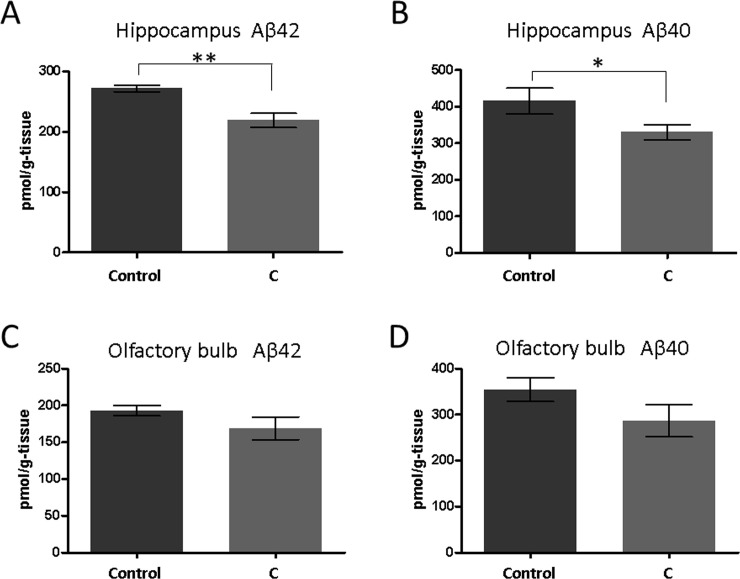
The amounts of Aβ42 and Aβ40 in the hippocampus (A, B) and the olfactory bulb (C, D) of the SAMP8 mice determined by ELISA. Mean ± SEM. **P = 0.0016 and *P = 0.046, Mann-Whitney test, n = 9 or 8.